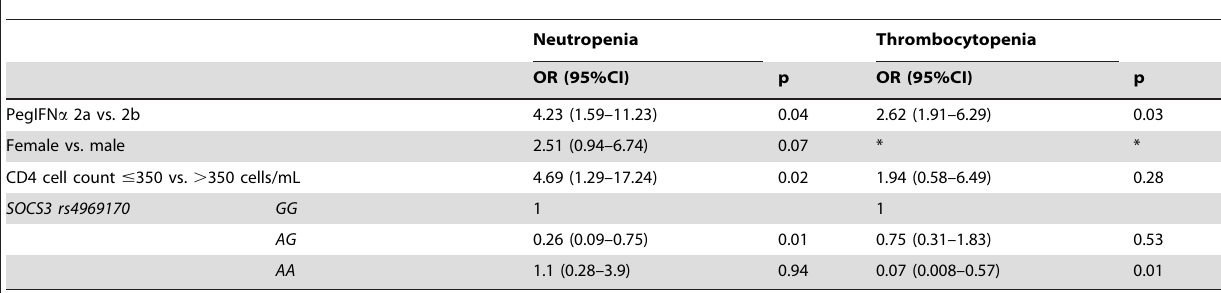
Table 7. Independent predicitive factors of adverse